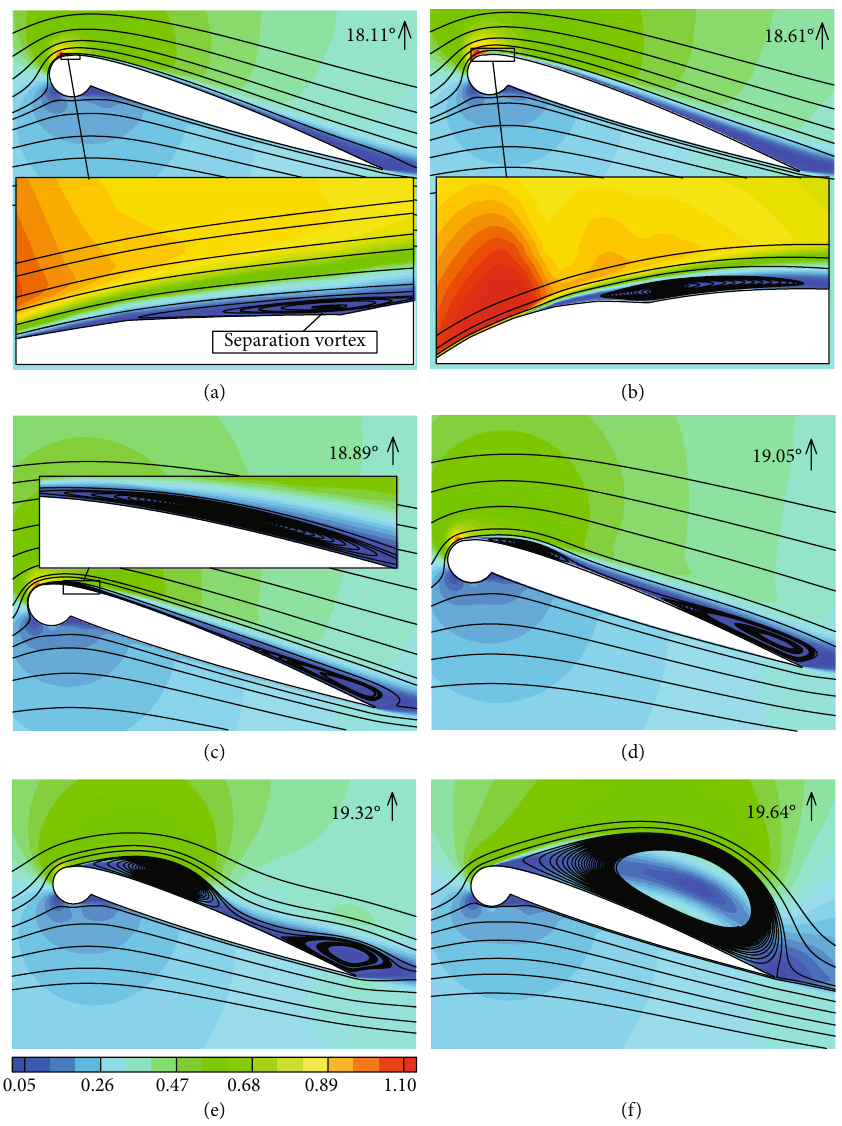
Figure 31: Streamlines and Mach number contours in Case 7 at di ff erent angles of